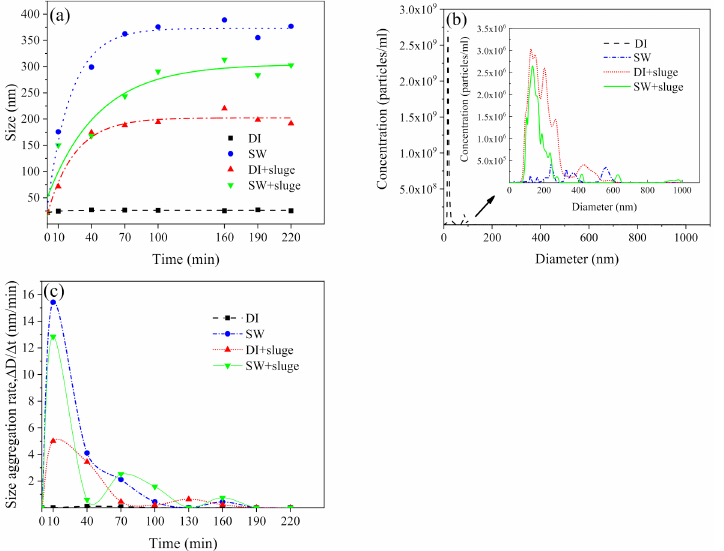
Figure 3. The effect of exposure time on the hydrodynamic size ( a ), size distribution ( b ), and aggregation rate ( c ) of DI − and SW − diluted cit − AgNPs (50 × dilution, 1.7 × 10 10 particles ml − 1 , 1.68 mg L − 1 ), with or without sludge. Notes: pH and IS in SW was 8.7 and 100 mM, respectively. HA in sludge was 42 mg L − 1 .